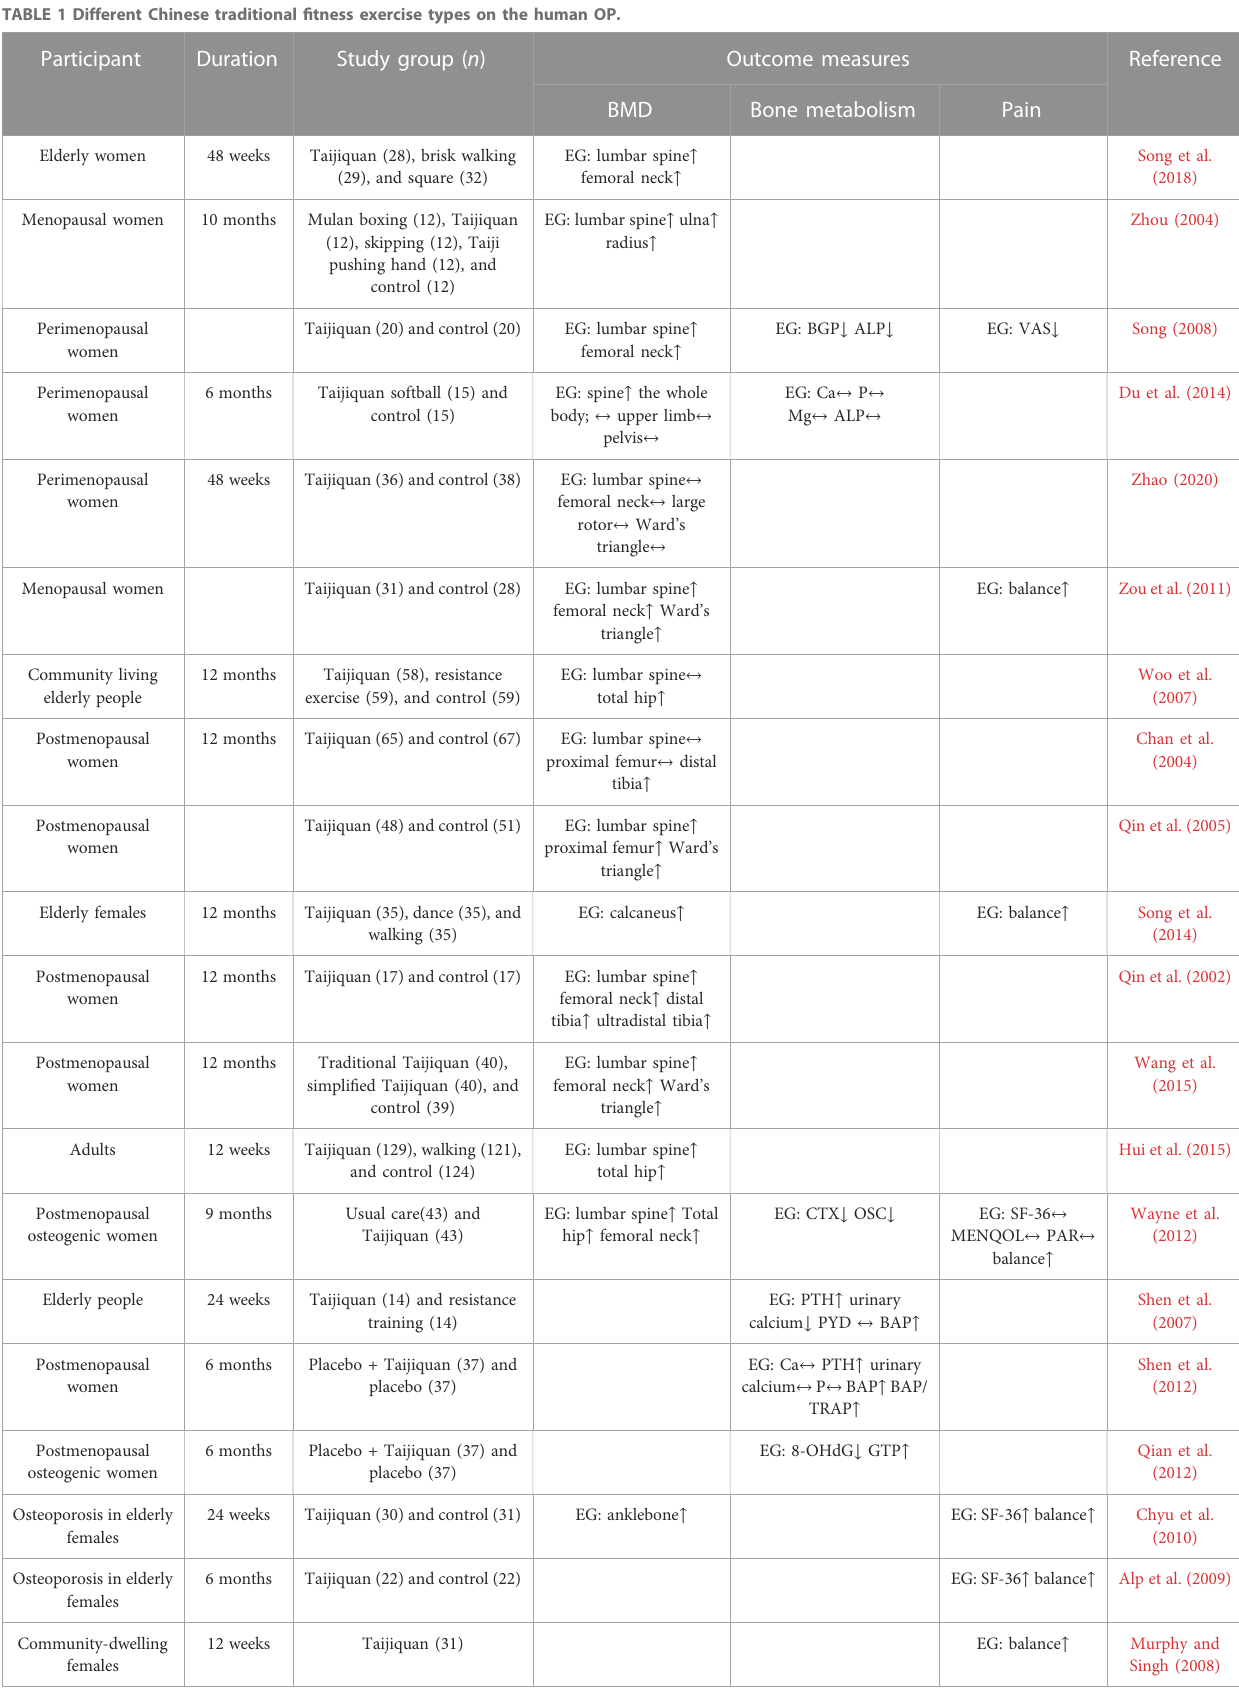
TABLE 1 Different Chinese traditional fi tness exercise types on the human